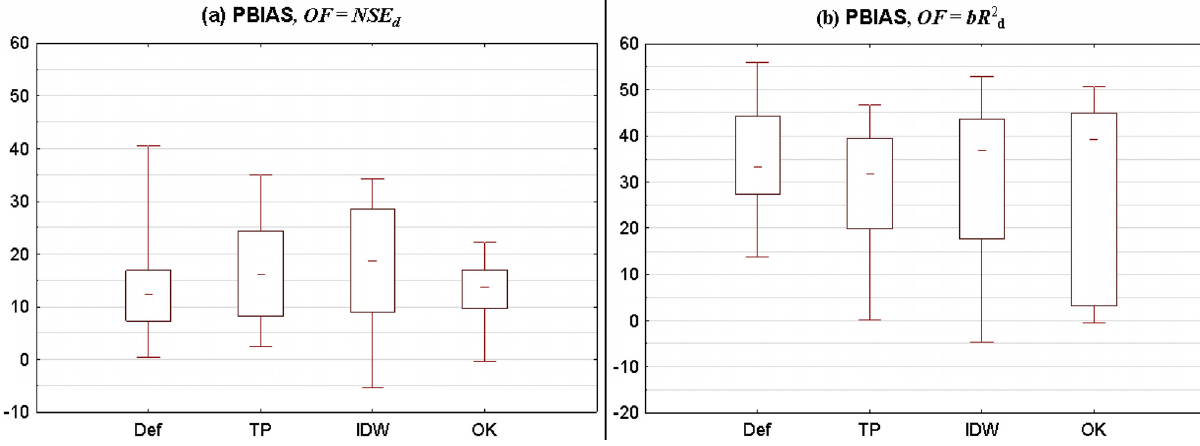
Figure 6. Box plots of selected objective functions across all 11 flow gauging stations for different interpolation methods (Def—Default version, TP—Thiessen Polygons, IDW—Inverse Distance Weighted, OK—Ordinary Kriging) and different temporal aggregations ( a , b : daily; c , d :